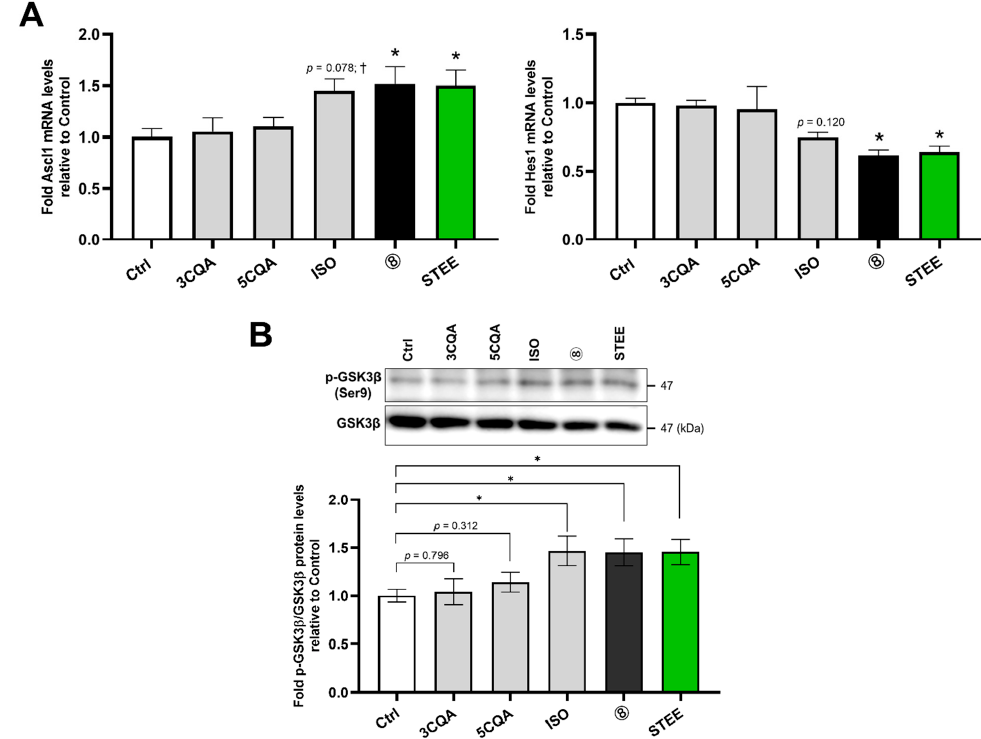
Figure 3. ISO in STEE regulated bHLH transcription factors expression in hNSCs. ( A ) Cells were treated with STEE and group 8’s compounds for 24 h. Ascl1 and Hes1 mRNA ( ASCL1 and HES1 ) levels were measured by qRT-PCR. The relative values are the mean ± SEM (n = 3–4) compared with the control. One-way ANOVA with Dunnett’s post hoc test for the comparisons: * p < 0.05; † p < 0.1. ( B ) Cells were treated with STEE and group 8 ′ s compounds for 60 min. p-GSK3 β and GSK3 β ex- pression were monitored by immunoblotting. The relative amounts are the mean ± SEM (n = 3) compared with the control. Student’s t -test (unpaired) for the comparisons: * p < 0.05. A description of the number for the treatment group is indicated in Table 1. Glycogen synthase kinase 3 β (GSK3 β ) is a serine/threonine kinase playing major